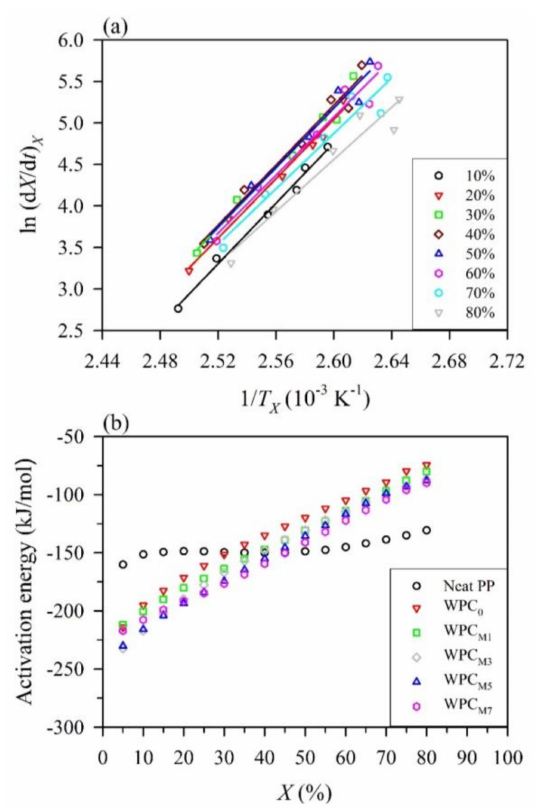
Figure 5. The non-isothermal crystallization kinetics of the neat PP and WPCs using the Friedman method. ( a ) Friedman plots of ln ( dX/dt ) X versus 1/ T X for the neat PP; ( b ) dependence of the effective activation energy on the relative crystallinities for the neat PP and